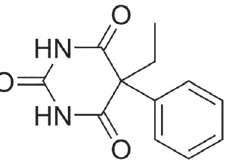
FIGURE 1 - Chemical structure of phenobarbital (Chemical formula: C H N O , Molecular weight: 232.2 g/mol, pKa: 7.4 12 12 2 3 and Log P :